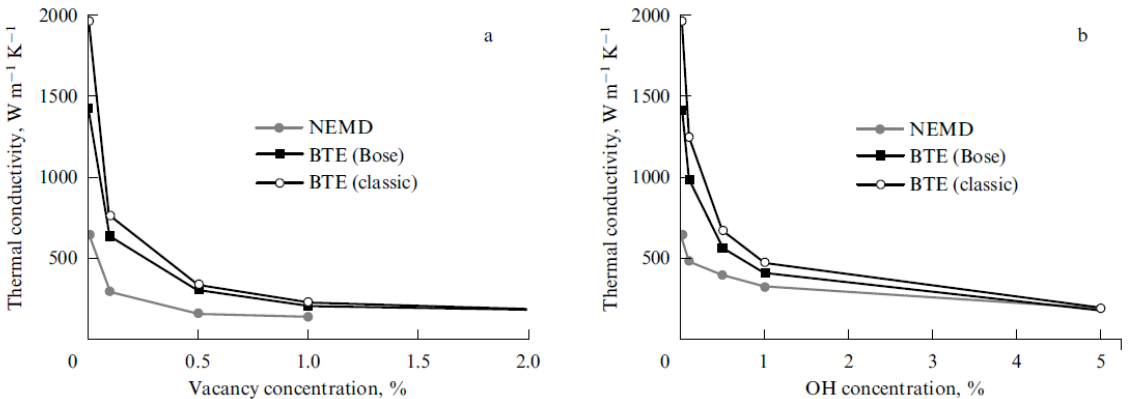
Figure 10. The thermal conductivity of a defective graphene sheet L = 1 μm in length as a function of the concentrations of vacancies ( a ), and OH groups ( b ) calculated using the NEMD method and the Boltzmann kinetic equation method with two types of phonon distribution statistics (classic and quantum Bose) [66].